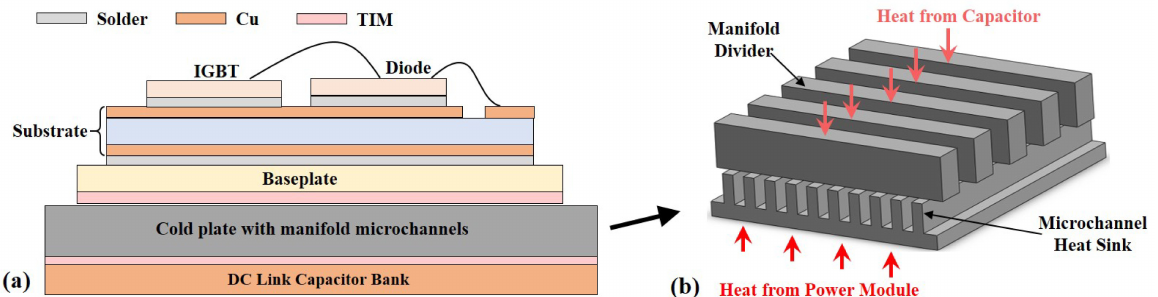
Figure 6. Schematic of ( a ) a cold plate with a sandwiched structure and ( b ) the cooling structure of manifold microchannels